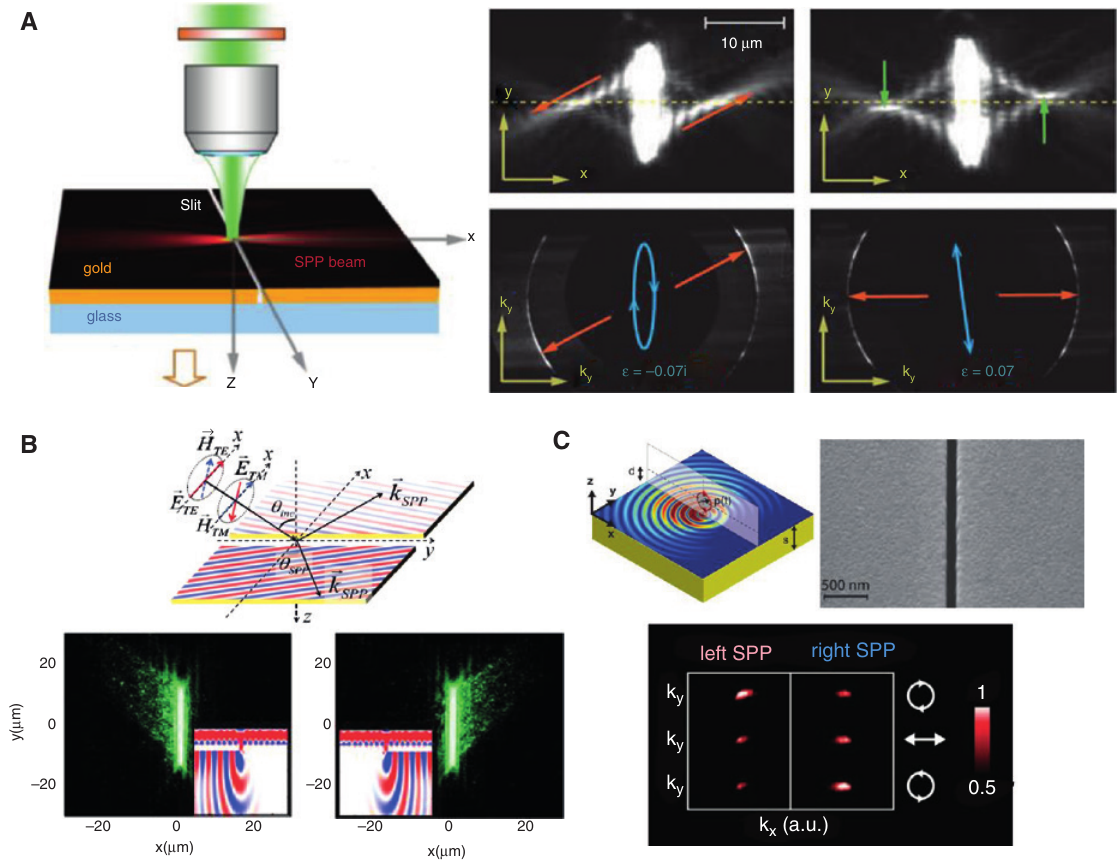
Figure 8: OSHE on a single nanoslot. (A) Observation of the spin-dependent shifting of scattered surface plasmon from a single nanoslot using the weak measurement approach. Left: Scheme of the experimental set-up. Right: SPP field distributions in real (top row) and Fourier spaces (bottom row) with different inci- dent polarizations are shown in cyan. Reproduced from Ref. [96]. (B) Exciting surface plasmon with different circular polarization on a long slit. Reproduced from Ref. [97]. (C) Asymmetric SPP emission from a single nanoslot and nanoparticle (top row). Reproduced from Ref.